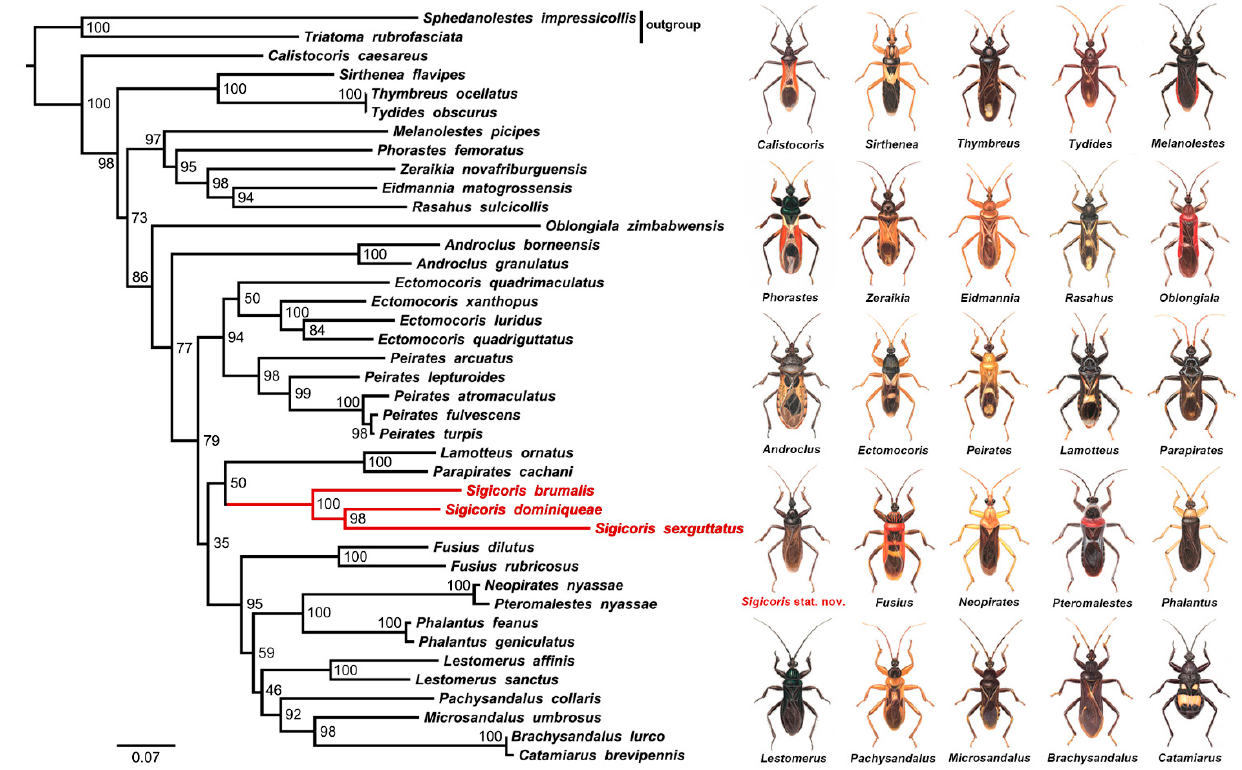
Figure 1. Phylogenetic tree of Peiratinae inferred via IQ-TREE based on concatenated genes ( COI + 16S + 18S). The nodal support indicates the bootstrap support values. Red branches highlight Sigicoris species and beside the tree are illustrations of the peiratine genera included in phylogenetic analysis.